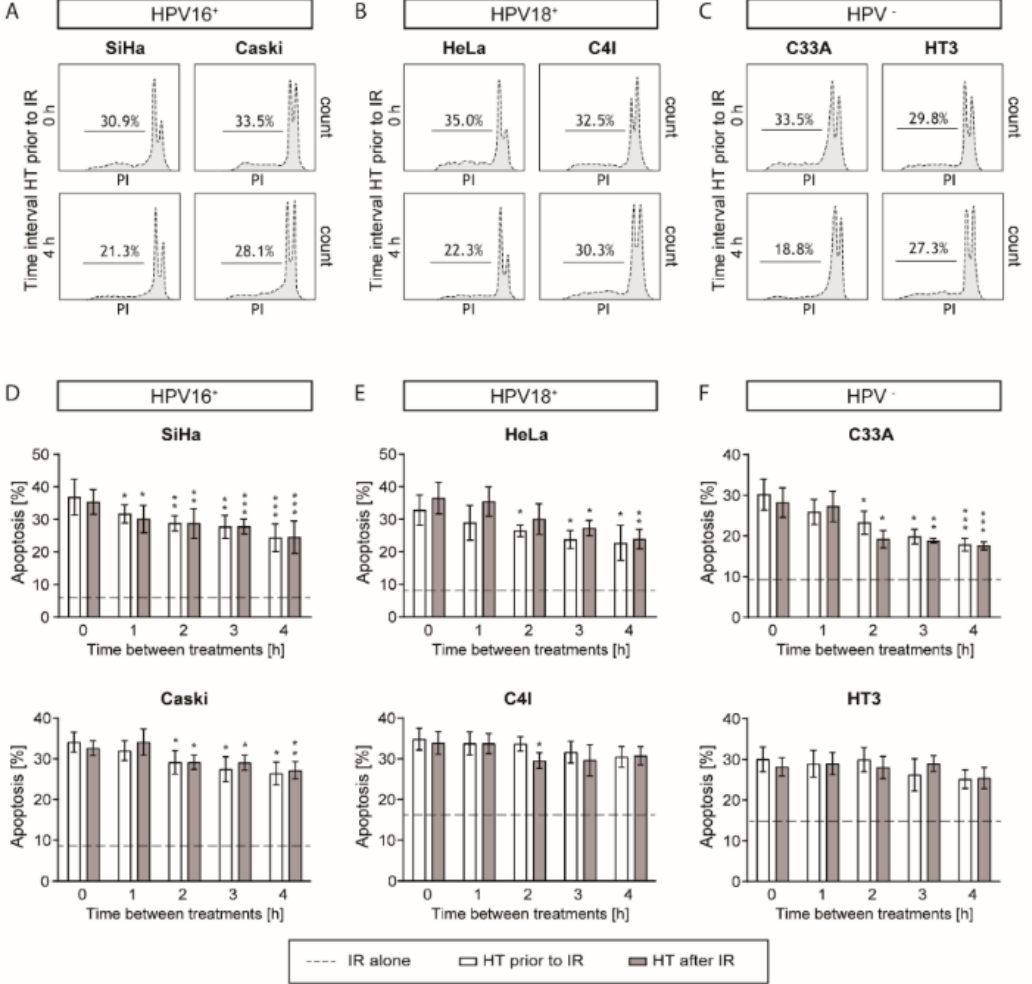
Figure 3. Higher levels of apoptosis were detected after shorter time intervals between